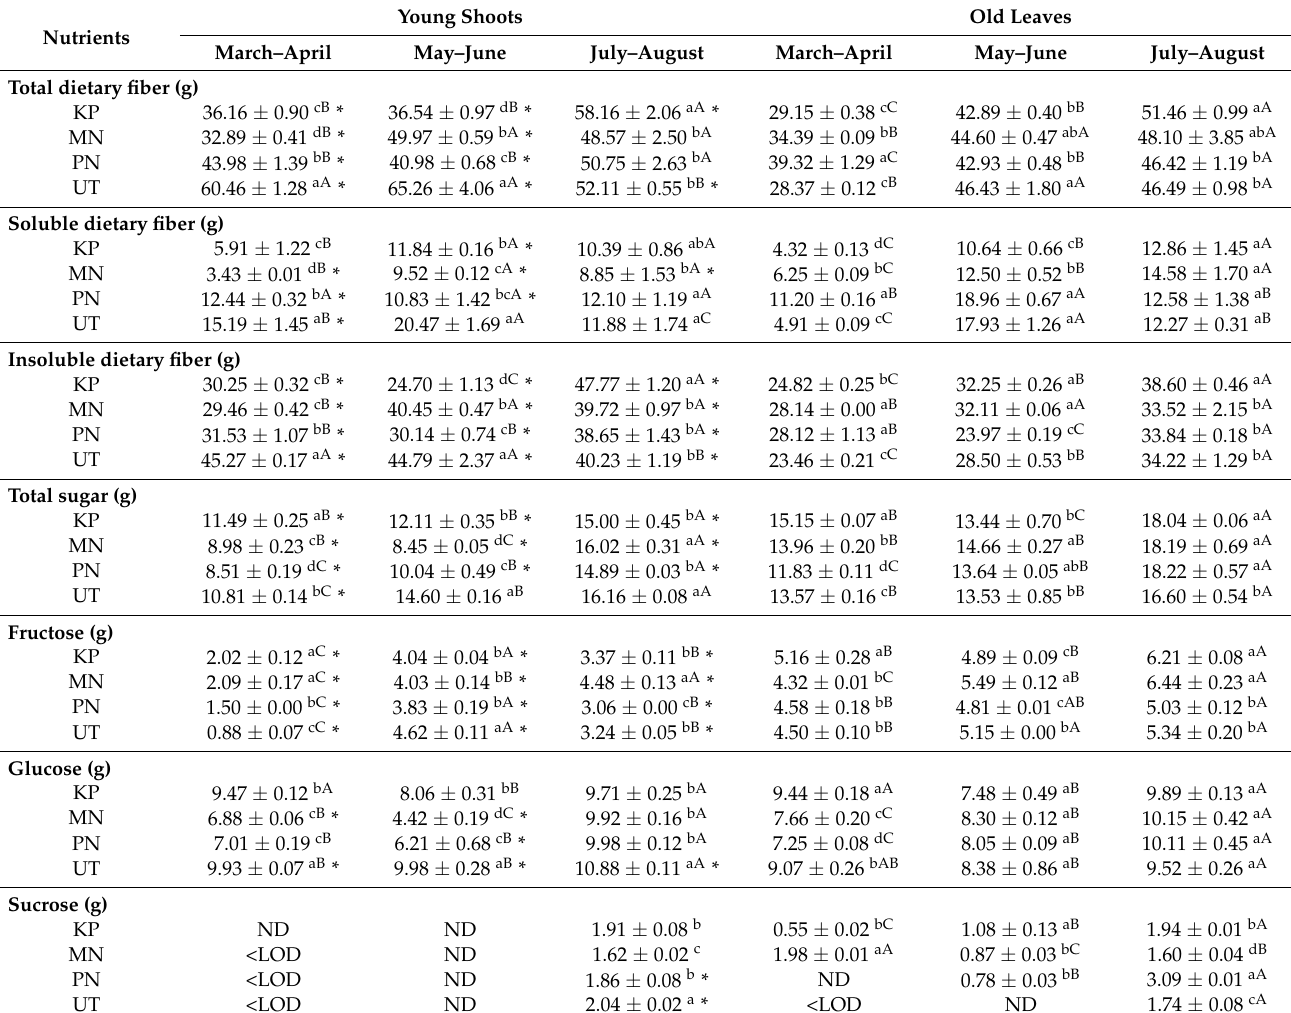
Table 3. Dietary fiber and sugar contents (per 100 g dry weight) in young shoots and old leaves of Adenia viridiflora Craib. from different origins including Kamphaeng Phet (KP), Muang Nakhon Ratchasima (MN), Pakchong Nakhon Ratchasima (PN), and Uthai Thani (UT) collected in different harvesting